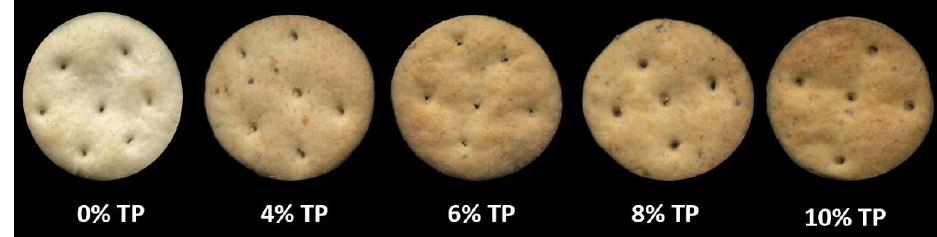
Figure 1. Cream crackers enriched with 0%, 4%, 6%, 8%, and 10% tomato pomace